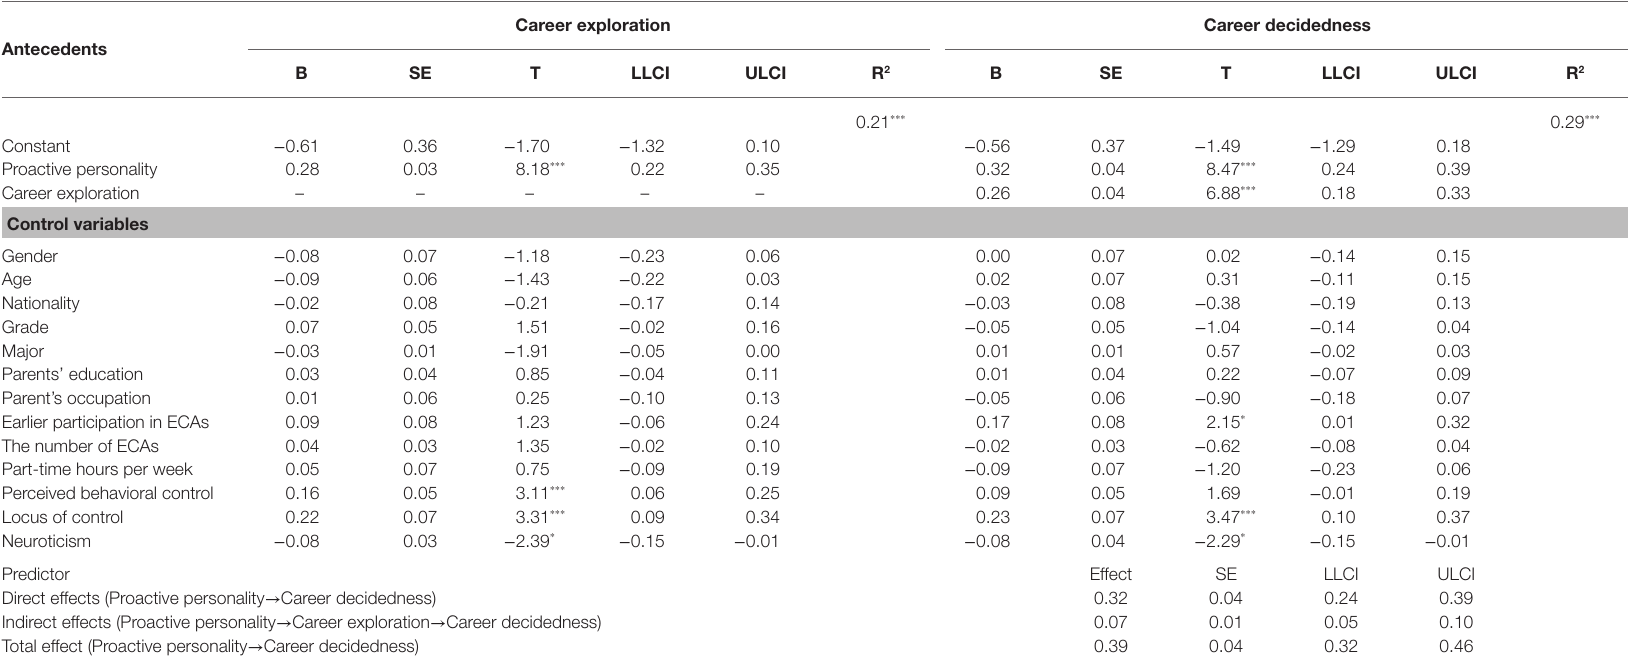
TABLE 4 | Results of mediation